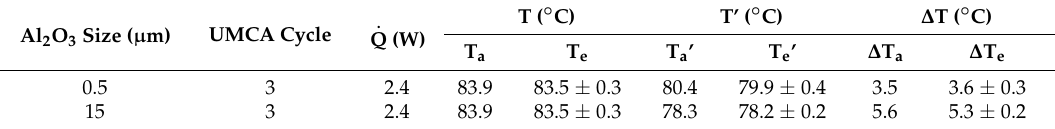
Table 3. Effects of powder size when comparing the temperatures obtained from the analytical model (all with subscript a) and the experiment (all with subscript e), using two Al 2 O 3 powder sizes (0.5 and 15 µ m), both for three UMCA cycles and both under the total heat input power of the top surface is 34% and 55% for 0.5 and 15 µ m, respectively.